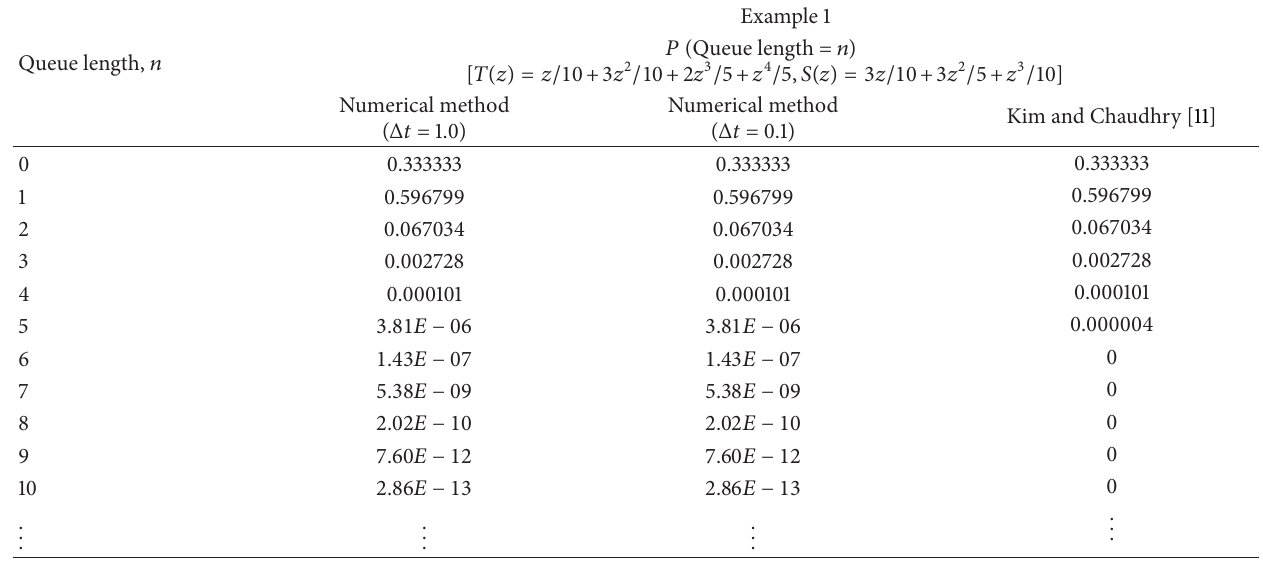
Table 4: Comparison of stationary queue length distribution computed using the proposed numerical method and that given in Kim and Chaudhry [11].